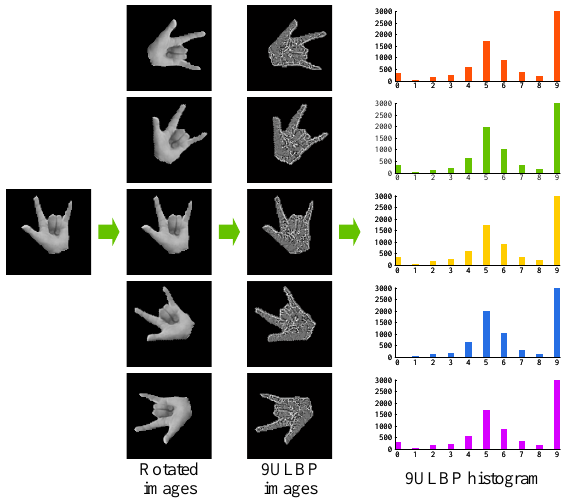
Rotated images Figure 8. Rotation invariance of 9ULBP